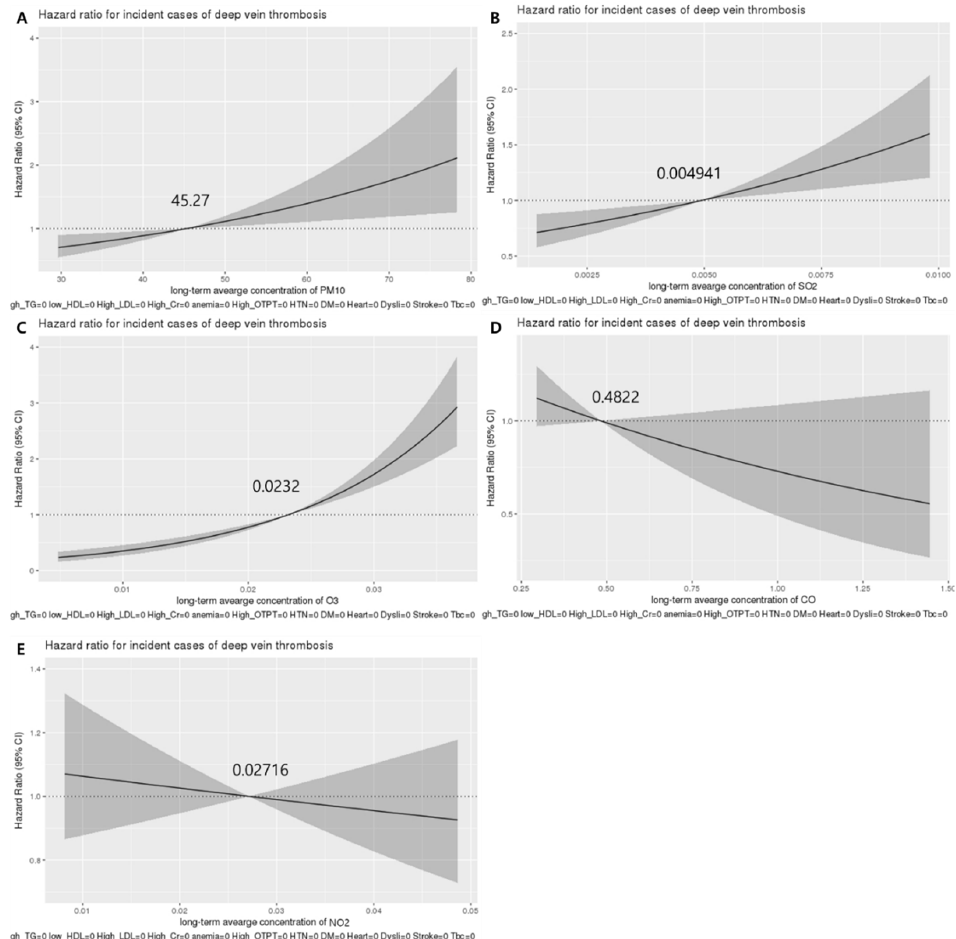
Figure 1. Concentration–response relationships between the incidence of venous thromboembolism and long-term average exposure to air pollutants including PM 10 ( A ), SO 2 ( B ), O 3 ( C ), CO ( D ), and NO 2 ( E ). The hazard ratio was adjusted for age, gender, economic status, body mass index, physical activity, smoking, alcohol consumption, comorbid diseases, and meteorological variables.